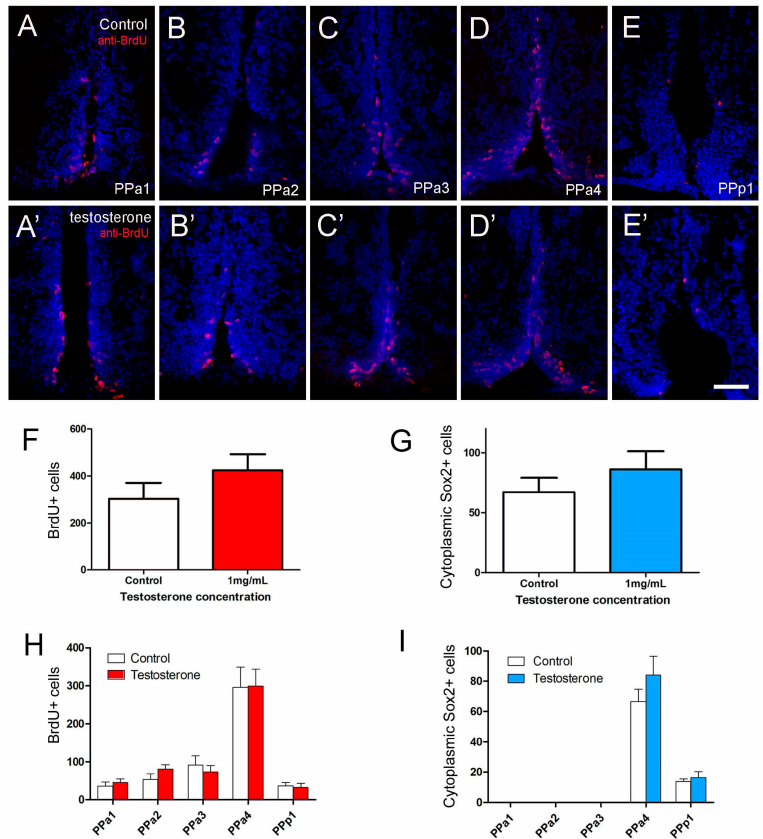
Figure 7. Testosterone did not affect cell proliferation in the POA. ( A – E , A’ – E’ ) Quantification of the effects of testosterone (1 mg/mL) in POA of adult zebrafish. The number of cells was counted in transverse 20 µ m cryosections of the POA (12 sections). ( A – E ) Testosterone control. ( A’ – E’ ) Testos- terone treatment (1 mg/mL). ( F ) Number of BrdU+ cells. ( G ) Number of cytoplasmic Sox2+ cells. ( H , I ) Number of cells located in the regions of the POA (20 µ m: PPa1 = 2, PPa2 = 2, PPa3 = 3, PPa4 = 4 and PPp1 = 2). All sections were labeled with DAPI (blue). Scale bar: 30 µ m.